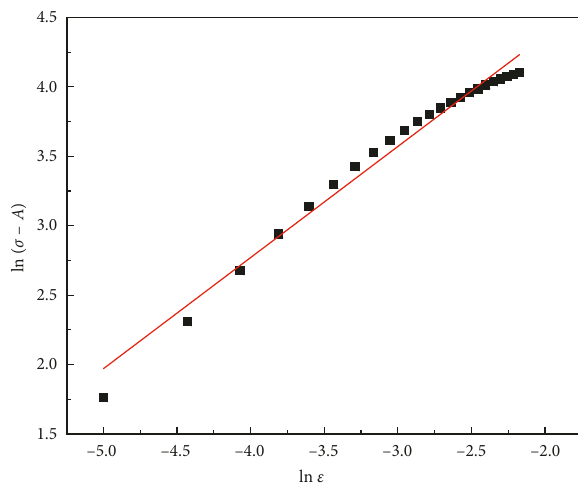
Figure 6: Relationship between ln